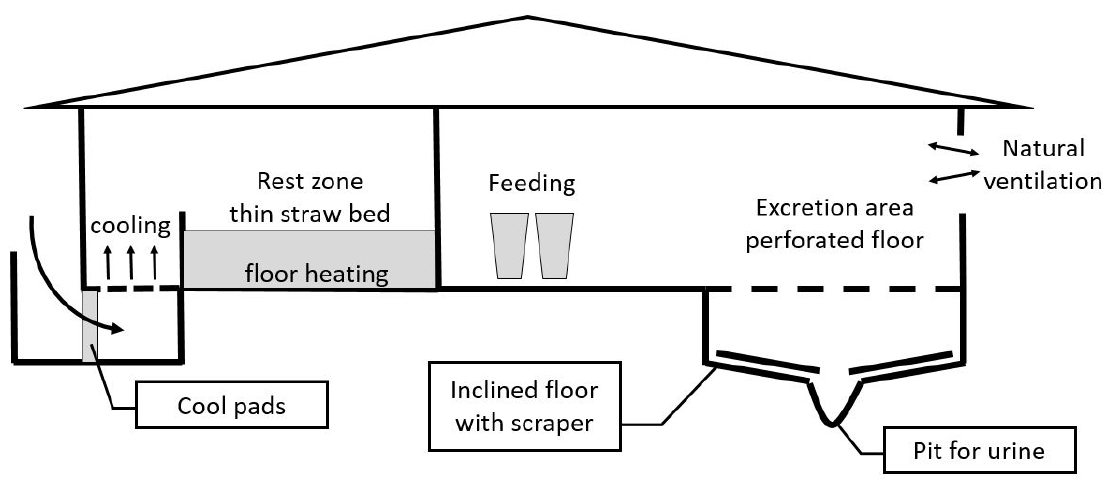
Figure 1. Sketch of the fattening piggery with the various areas for resting, feeding and excretion.